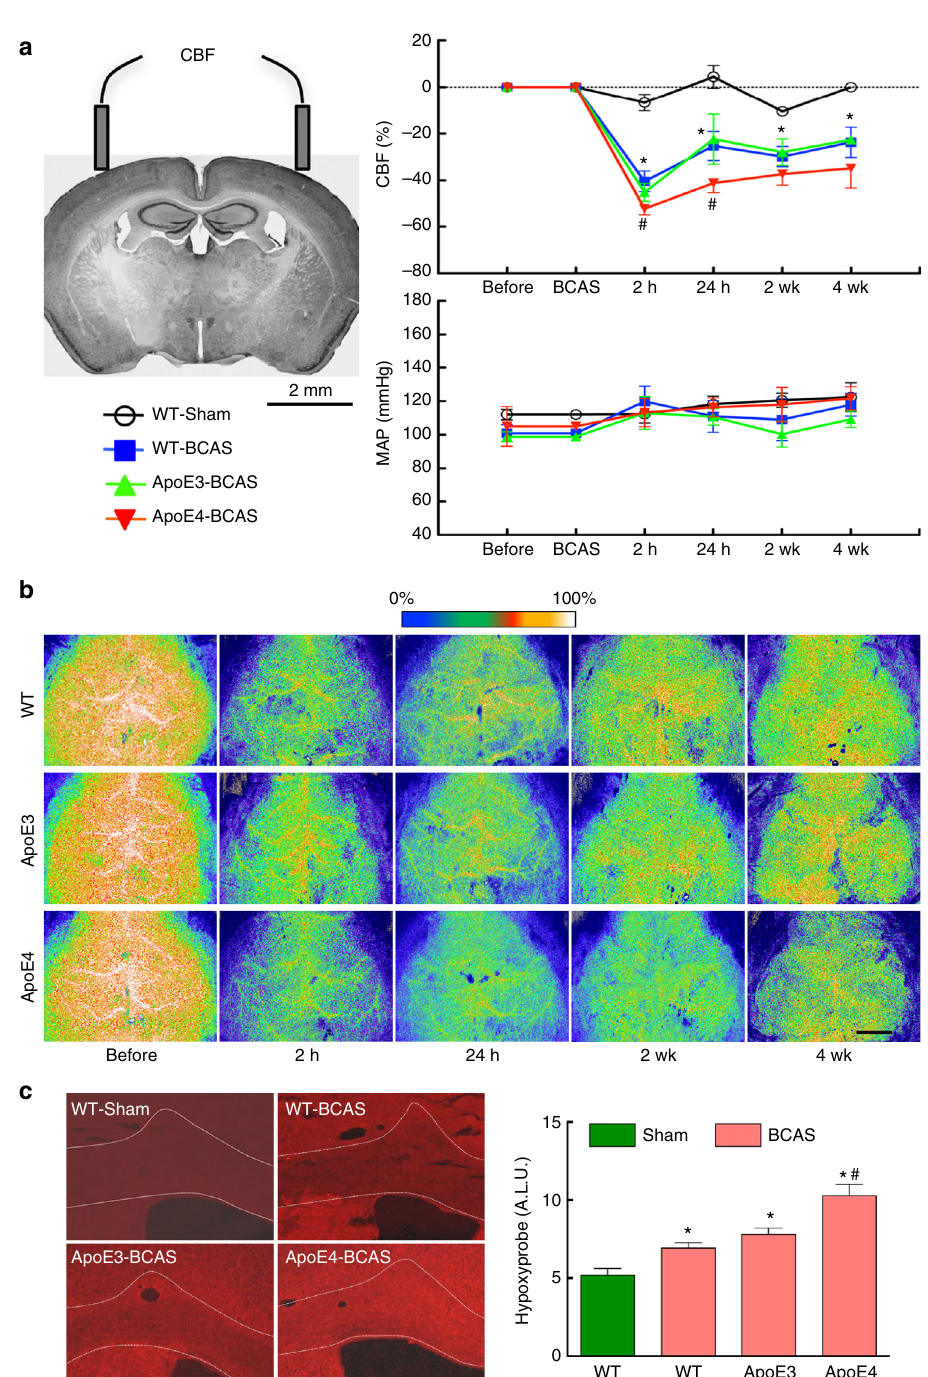
Fig. 3 Worse cortex CBF and CC hypoxia in ApoE4-TR mice after BCAS. a Neocortical CBF and mean arterial pressure (MAP) recorded at the indicated times over 4 weeks before or after sham surgery (WT) or BCAS in WT (WT-Sham or -BCAS), ApoE3 (ApoE3-BCAS), and ApoE4 (ApoE4-BCAS) mice. Right and left CBF values were not different and were averaged. The CBF reduction induced by BCAS is more marked in ApoE4-TR mice. b Representative laser speckle images of CBF before or after BCAS in WT, ApoE3-TR, and ApoE4-TR mice, con fi rming the greater CBF reduction in ApoE4-TR mice (see Supplementary Fig. 7C for quanti fi cation). Scale bar = 2 mm. c The intensity of the hypoxyprobe signal, a marker of tissue hypoxia, is more pronounced in the CC of ApoE4-TR mice, compared to WT or ApoE3-TR mice. Data are expressed as means ± SEM. Scale bar = 250 µ m. N = 5/group; * p < 0.05 from WT-sham; # p < 0.05 from WT and ApoE3-BCAS; one-way ANOVA and Tukey ’ s test. ALU arbitrary fl uorescent intensity